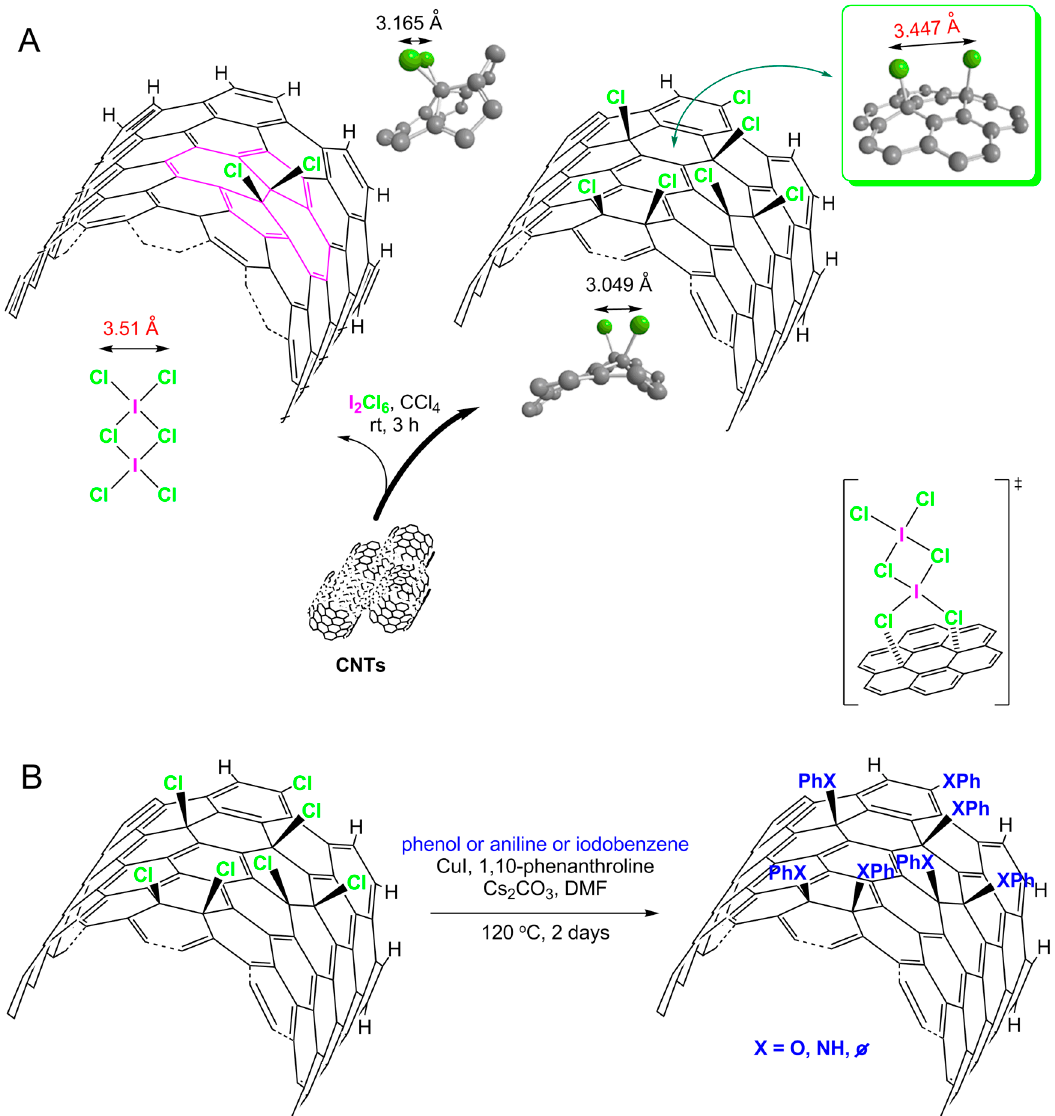
Figure 1. General scheme of the preferential sites of chlorination of carbon nanotubes (CNTs) by their treatment with ICl 3 ( A ); optimized conditions for Ullmann-type reactions of CNTs ( B ); for clarity, only a fragment of the (outer) nanotube wall is shown; ∅ stands for an empty set, i.e., no atoms in the case of C -arylation. The figure was prepared on the basis of a hypothesis made by Abdelkader et al. [33].